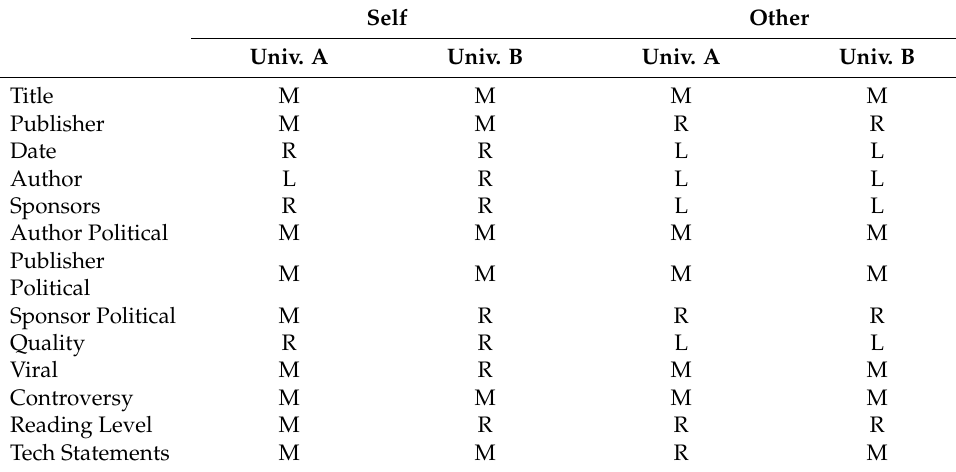
Table 5. Metrics with indication of a 10 percentage point difference between self and ideal perception or other and ideal perception by school. ‘M’ indicates there is too much usage of this metric and ideally would be less. ‘L’ indicates there is too little usage of this metric and would ideally be more. ‘R’ indicates that the perception of real use is within 10 percentage points of the perception of ideal use for this metric.